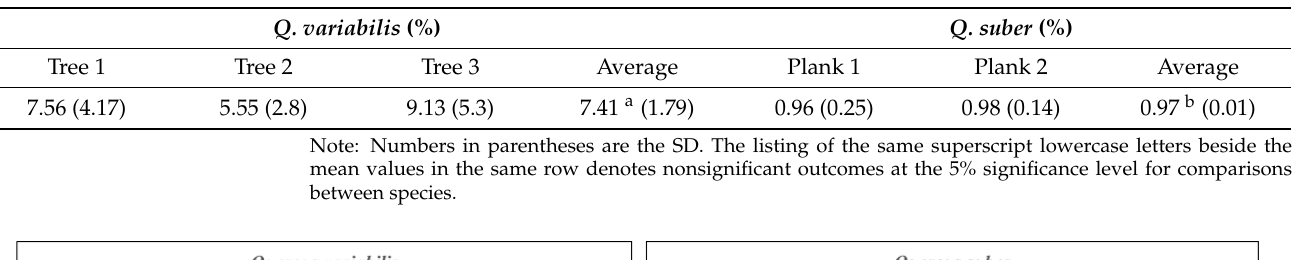
Figure 3. Variation in growth ring width from the cork back to the phellogen in Q. variabilis virgin cork and Q. suber reproduction cork.